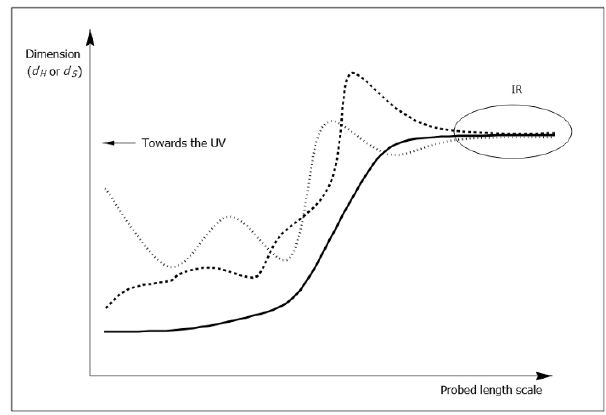
Figure 1 . The central hypothesis of the theorems on dimensional flow described in the